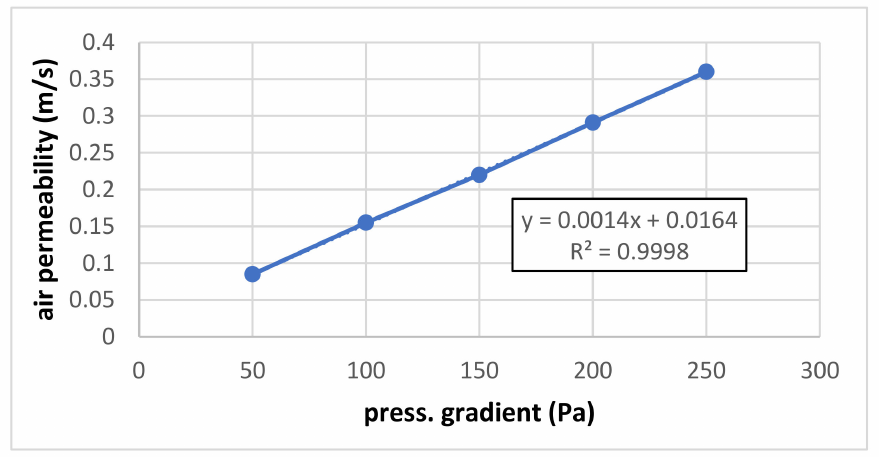
Figure 3. Air permeability for small pressure